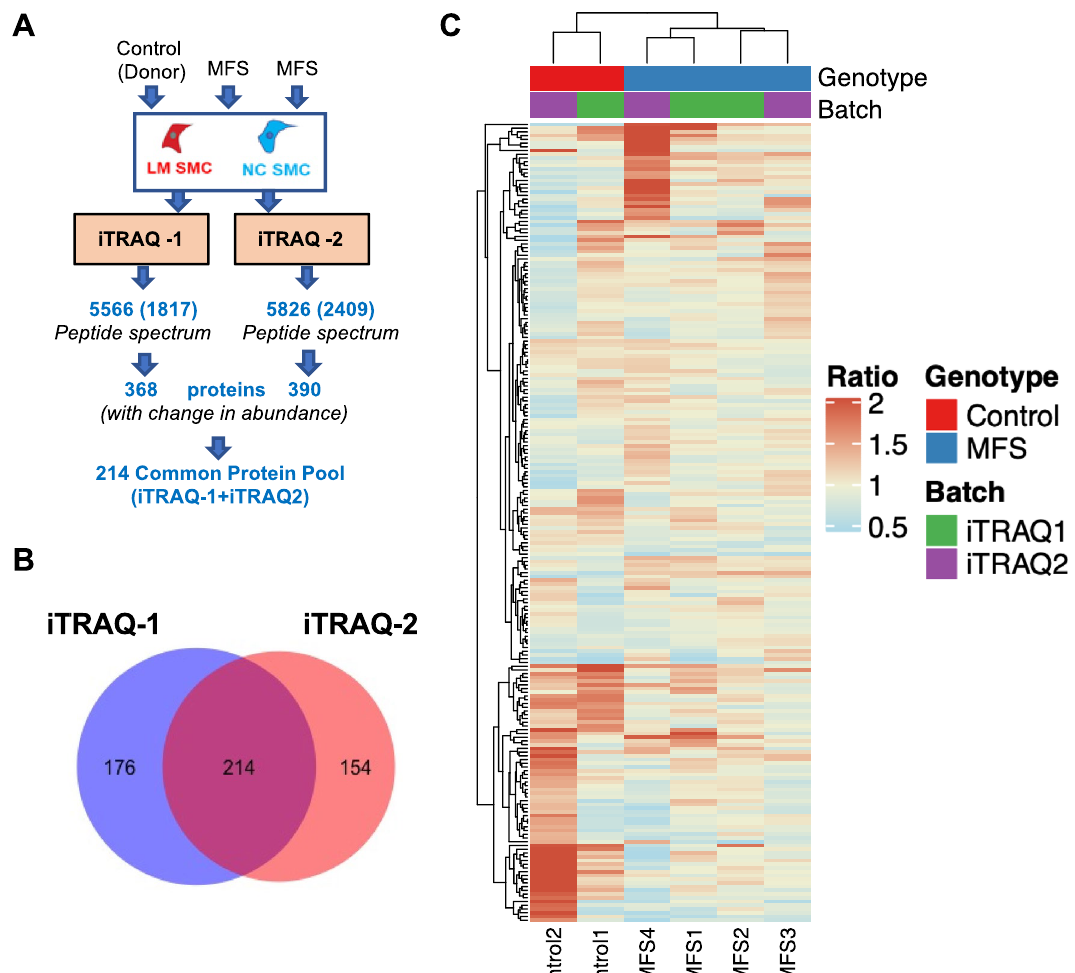
Figure 2. Bioinformatic analysis reveals distinct lineage-specific proteomic profile of Marfan syndrome (MFS) iPSC SMCs compared to donor control. ( A ) Technical description of two independent iTRAQ experiments (workflow and data paring). ( B) Data merging between two iTRAQ runs resulting in “common” protein pool of 214 proteins represented in both experiments selected for further analysis. ( C ) Hierarchical clustering of iPSC SMC iTRAQ data from MFS patients (n = 4) and controls (n = 2) for common 214-protein pool. Each sample analyzed for ratio of expression between LM and NC lines from the individual patient. Samples cluster primarily by disease vs. control, rather than iTRAQ